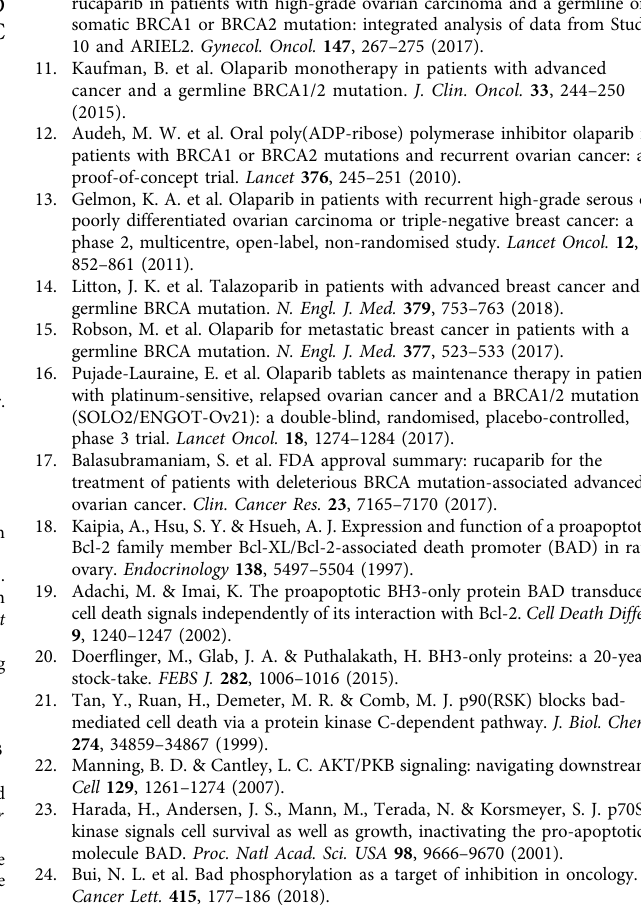
Fig. 5 NPB and Olaparib synergize to suppress the growth of cisplatin-resistant EOC xenografts. A Xenograft: A2780 or A2780 cisplatin-resistant (5 × 10 6 ) cells were injected subcutaneously into the fl ank of 5-week-old BALB/c athymic mice, respectively. When the xenograft reached 100 – 150 m 3 , in each cell line group, the mice were randomized into the four indicated treatment groups ( n = 6). Mice were treated daily with vehicle (V), 20 mg/kg NPB (N), 50 mg/kg Olaparib (O), or a combined NPB-Olaparib by i.p. injection. Xenograft growth was monitored daily by the measurement of the xenograft volume. The statistical change between treatment groups was analyzed using a one-way ANOVA followed by a Tukey ’ s multiple comparison test on endpoint xenograft volume. Mean animal weights of each treatment group are indicated. Animal weight was monitored daily. The yellow triangle points to the start of the treatment. The brown triangle points to the end of the treatment. Results represent the mean ± SEM of six animals. B Mice were treated daily with vehicle (V), 20 mg/kg NPB (N), 50 mg/kg Olaparib (O), or a combined NPB-Olaparib by i.p. injection. Xenograft weight: mean xenograft weight of each treatment group after sacri fi ce on the 8th day. Results represent the mean ± SEM of six animals. C Immunohistochemistry evaluation: pBADS99, BAD, KI67, cleaved-CASP3/7, and TdT-mediated dUTP Nick-End Labeling (TUNEL) positivity was assessed in resected xenografts treated with vehicle (V), 20 mg/kg NPB (N), 50 mg/kg Olaparib (O) or a combined NPB-Olaparib by i.p. injection using immunohistochemistry (IHC) as described in the methods. Quanti fi cation of positive staining cells from the indicated treatment group for pBADS99, BAD, KI67, cleaved-CASP3/7, and TUNEL are shown in individual value plots ( n = 6). D Patient-derived xenograft: con fl uent cultured cancer (5 × 10 6 ) cells from the patient ’ s ascites were injected subcutaneously into the fl ank of 5-week-old BALB/c athymic mice. When xenografts reached 150 – 200 m 3 , the mice were randomized into the four indicated treatment groups ( n = 6). Mice were treated daily with vehicle (V), 20 mg/kg NPB (N), 50 mg/kg Olaparib (O) or combined NPB-Olaparib by i.p. injection for 21 days. Xenograft growth was monitored daily by measurement of the xenograft volume until the humane endpoint. Below: the mean animal weights of each treatment group are indicated. Animal weight was monitored daily. Results represent the mean ± SEM of six animals. E Kaplan – Meier curve: Kaplan – Meier survival curves showed median survival to the humane endpoint and surrogate survival rate in the vehicle (V), NPB (N), Olaparib (O), or a combined NPB- Olaparib-treated group. Six animals in each group. Log-rank test χ 2 = 75.0054. p < 0.001. F The drug response evaluation: waterfall plot of responses to the vehicle (V), NPB (N), Olaparib (O), or a combined NPB-Olaparib are described by xenograft volume changes (%) from Best Average Response (The minimum value of the average of Δ Volt for t ≥ 10 d); each bar represents an individual PDX. The criteria for response (mRECIST) was used to make response calls (as described in “ Methods ” ). mRECIST were de fi ned as followed: complete response (mCR): best response < − 95% and best avg